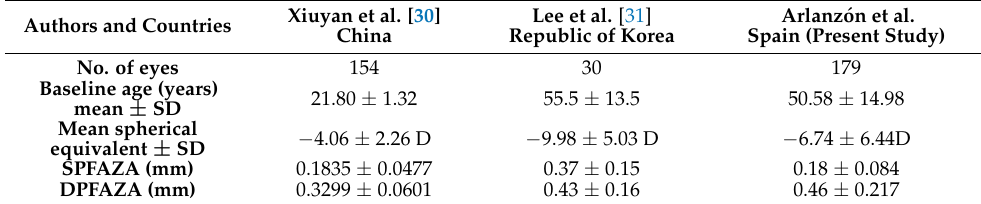
Table 3. Comparison of the FAZ Measurements among Different Studies.